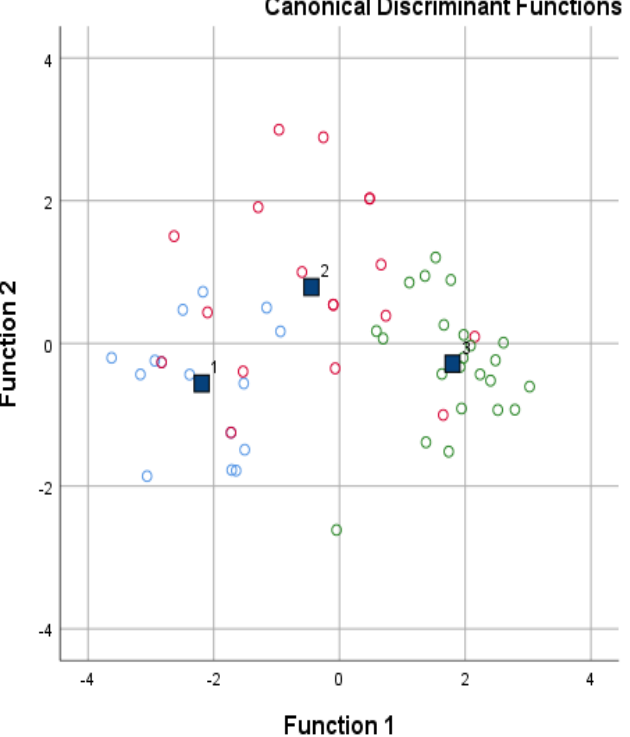
Figure 2. Discriminant classification plot.